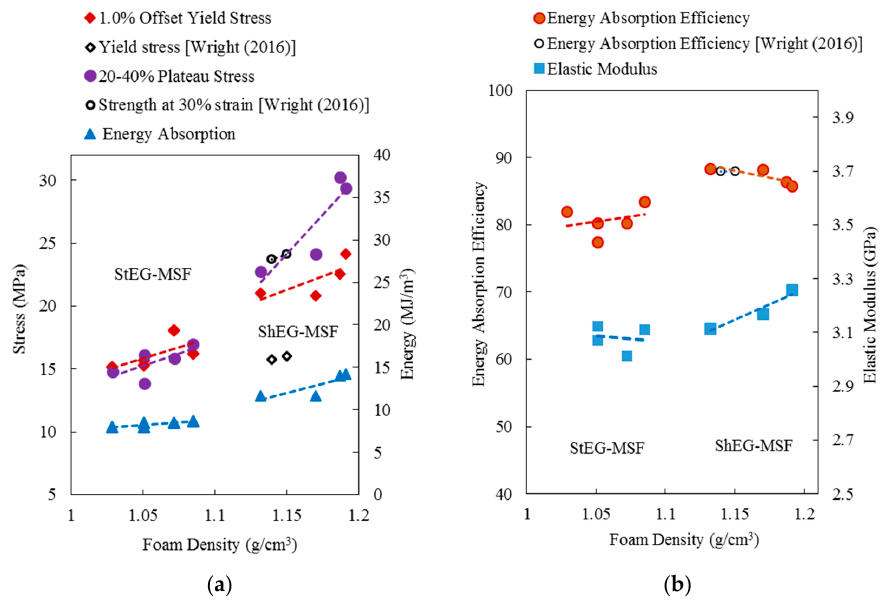
Figure 8. Mechanical properties of EG-MSF versus with the foam density: ( a ) plateau stress and energy absorption; and ( b ) elastic modulus and energy absorption efficiency. Additional data points received from Wright et al. [28].